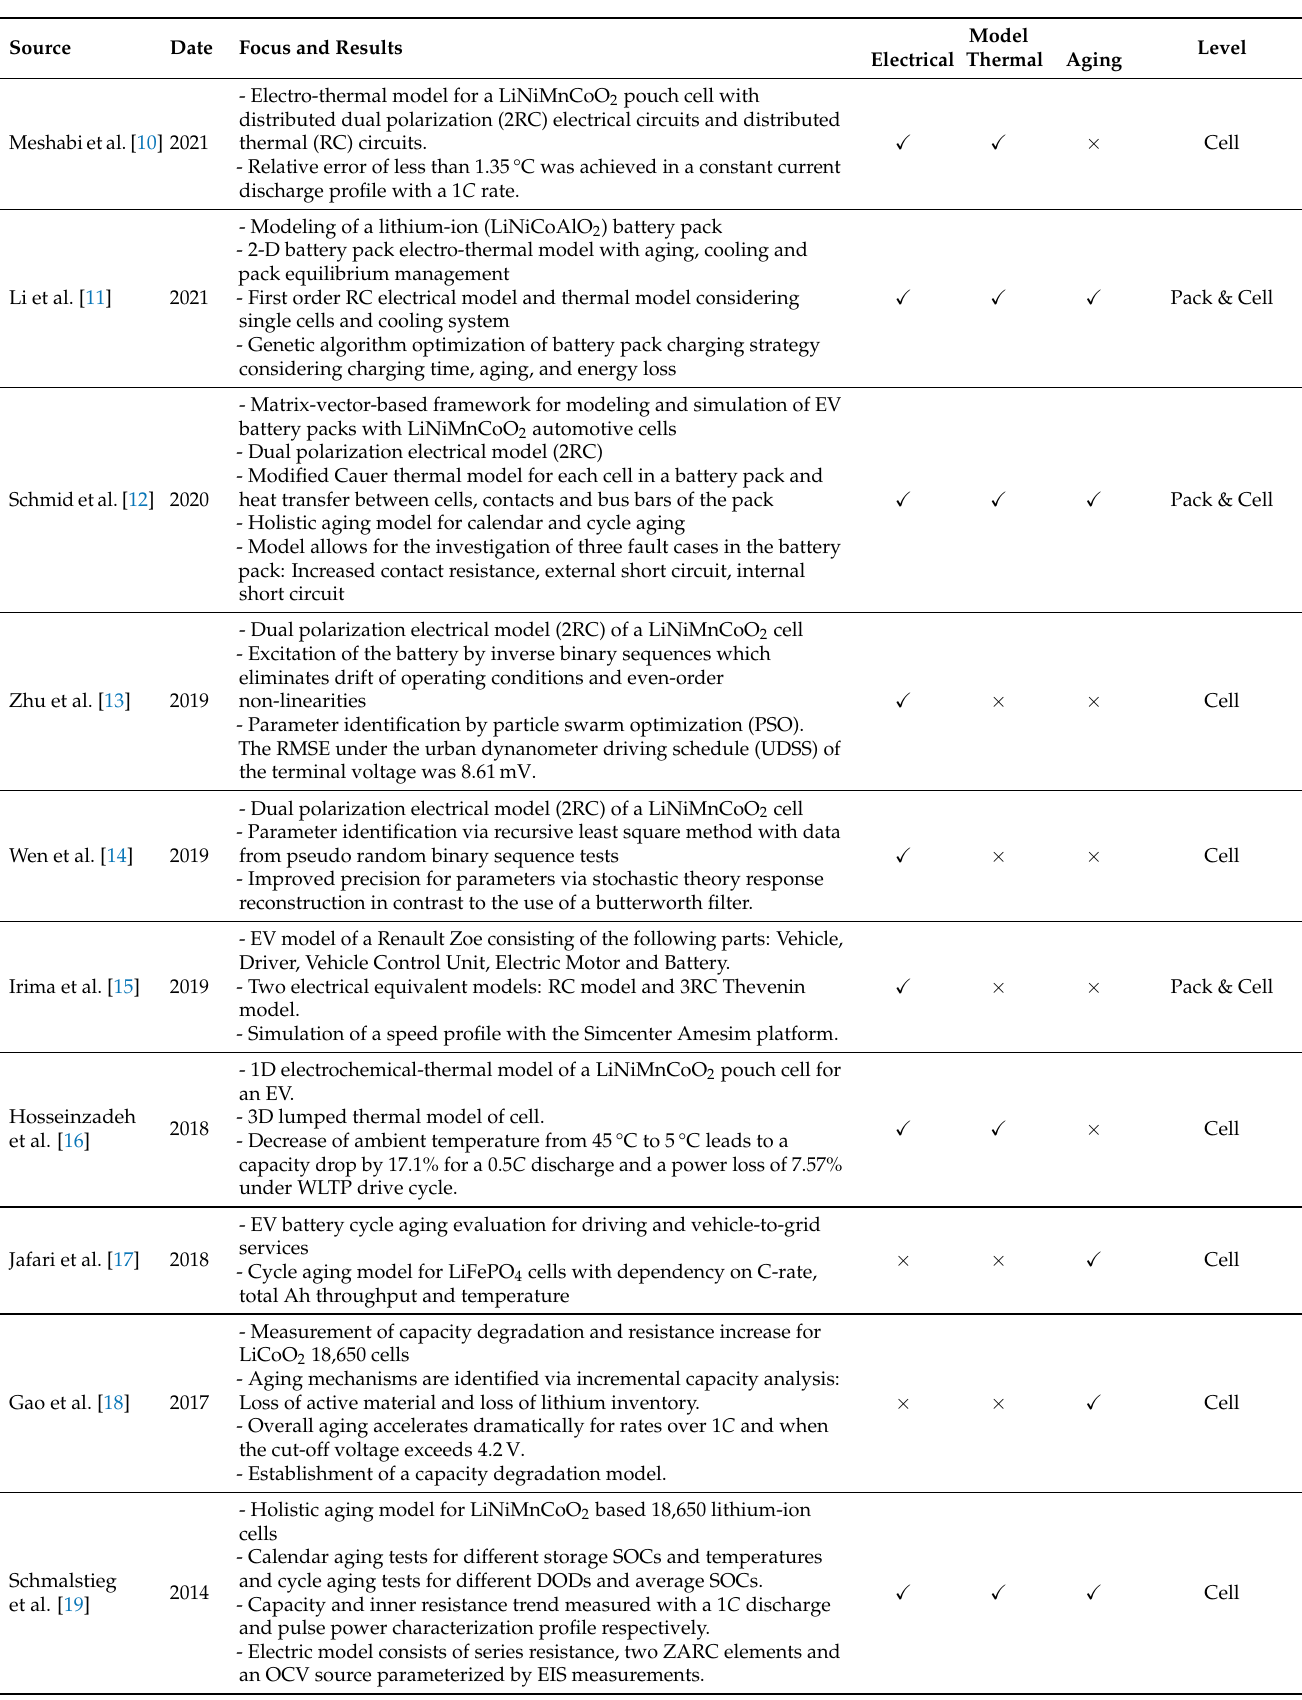
Table 1. Summary of selected literature about li-ion battery and EV